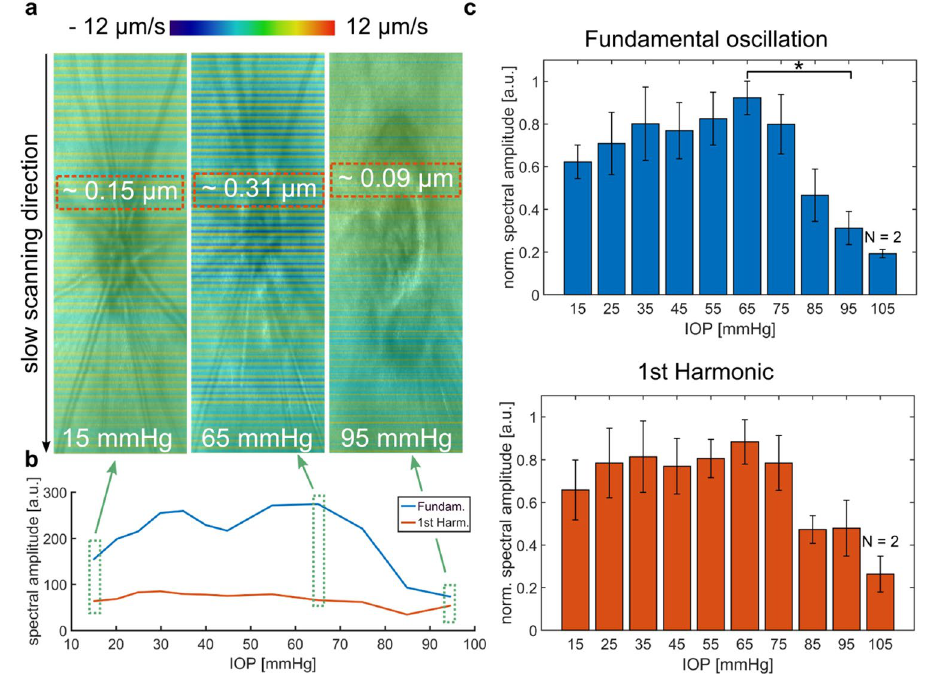
Figure 3. Spectral analysis of ocular fundus pulsations as a response to an elevated IOP. ( a ) Pulsation changes illustrated as a color-coded overlay on the en-face reflectivity projections at three different IOP levels (15, 65, and 95 mmHg). A stronger stripy pattern, in comparison to the initial IOP level, was noticed at IOP of 65 mmHg while the pulsations almost vanished at 95 mmHg. ( b ) Pulsatile response to an increased IOP shown for one rat exemplary. ( c ) Pulsatile response to an elevated IOP for four rats (N = 4) in a range of 15 to 105 mmHg. Error bars indicate the standard deviation. The spectral amplitude was normalized for each rat to the maximum spectral response. A significant drop was noticed between 65 mmHg and 95 mmHg in the fundamental osciallation. The analysis of the first harmonic showed a similar behavior, but no statistically significant trend was observed. ( * significant difference: p <